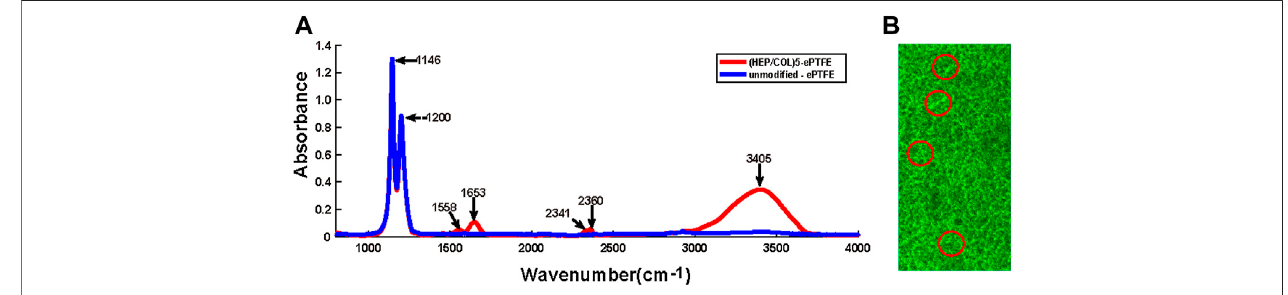
FIGURE2| Con fi rmationoftheassemblyofheparin,collagenandREDV,Arg-Glu-Asp-Val;peptidesonePTFE,expandedpolytetra fl uoroethylenemembranes. (A) Fourier-transform infrared (FTIR) spectroscopy of unmodi fi ed ePTFE and ePTFE modi fi ed with 5 bilayers of heparin and collagen (HEP/COL)5 (B) Confocal laser scanning microscopy illustrating the distribution of REDV peptides on modi fi ed ePTFE membranes (areas of green fl uorescence circled in red color); scale bar = 75 µm.